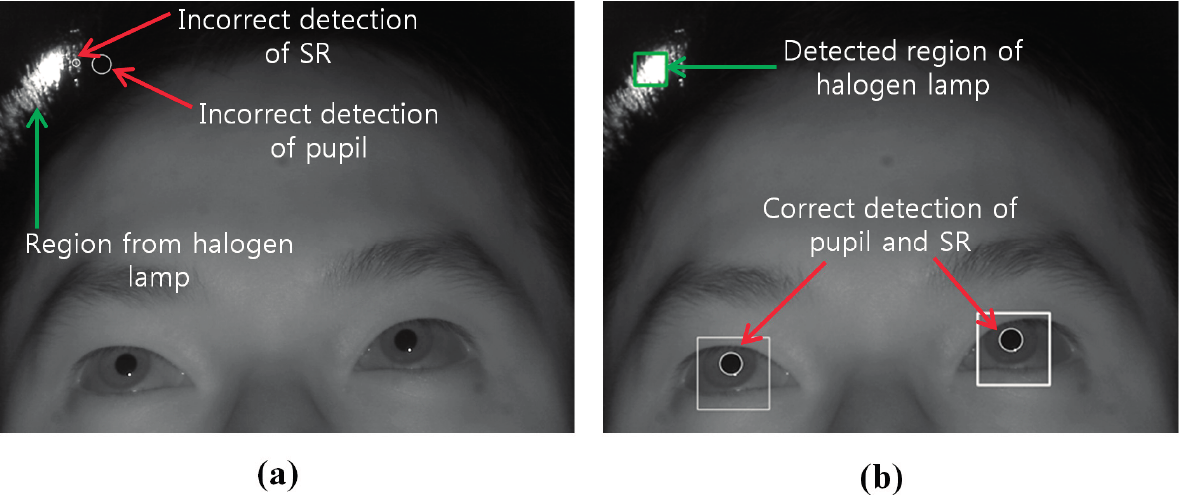
Figure 22. Experiments when a halogen lamp is located behind the user.